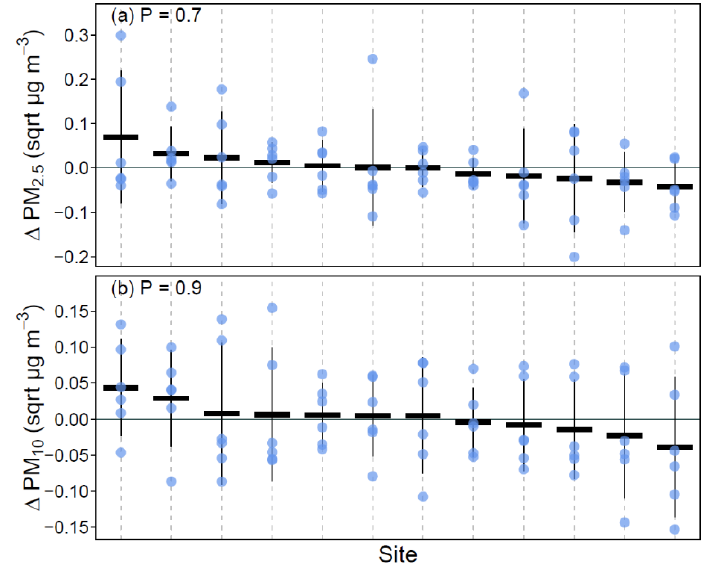
Figure 3. Plots of ∆ PM 2.5 ( a ) and ∆ PM 10 ( b ). Blue points show the ∆ PM values, thick black horizontal lines represent the means for the sites, and thin vertical black lines the 95% confidence interval of the mean for the sites. The p -value at the top of each plot is the result from a joint test of model coefficients with the null hypothesis that the sites do not differ from zero. Sites are sorted on the x -axis by their mean value (highest to lowest) for ease in interpretation. The solid horizontal line indicates zero on the y -axis, representing equal values of PM at the green wall and reference wall.